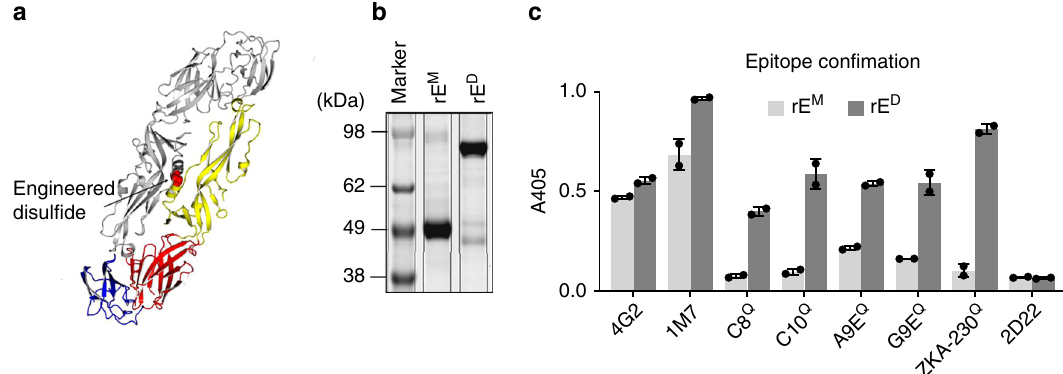
Fig. 1 Expression pf ZIKV rE monomers and rE homodimers. a The soluble ZIKV rE-monomer (rE M , aa1 – 404) was expressed and puri fi ed from mammalian cells. The soluble stable ZIKV rE-homodimer (rE D ) was generated by an A264C substitution, resulting in a disul fi de bridge in the E-domain II dimer interphase (yellow). b Puri fi ed rE M and rE D were analyzed by SDS-PAGE and exhibited predicted molecular weights of ~49 kDa (monomer) and ~98 kDa (dimer). c Binding of ZIKV speci fi c (A9E, G9E, and ZKA-230) and fl avivirus cross-reactive (4G2, 1M7, C8, and C10) mAbs to ZIKV rE M and rE D was analyzed. Binding of mAbs that have a quaternary footprint (Q) was only observed for rE D . The DENV2 speci fi c mAb 2D22 was used as a negative control. Results from n = 2 independent experiments are shown. Error bars represent standard deviation. Source data are provided as a Source Data fi